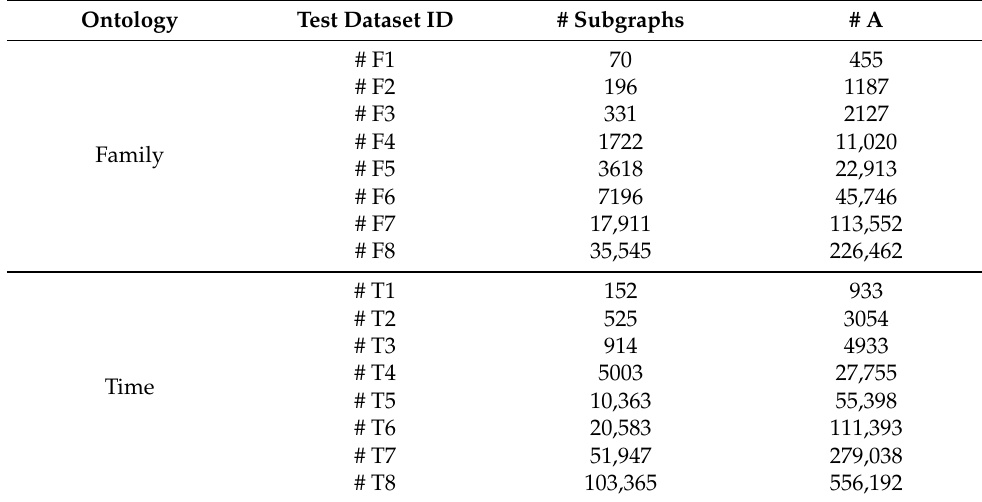
Table 3. Statistics of the Independent Test Dataset Used in the